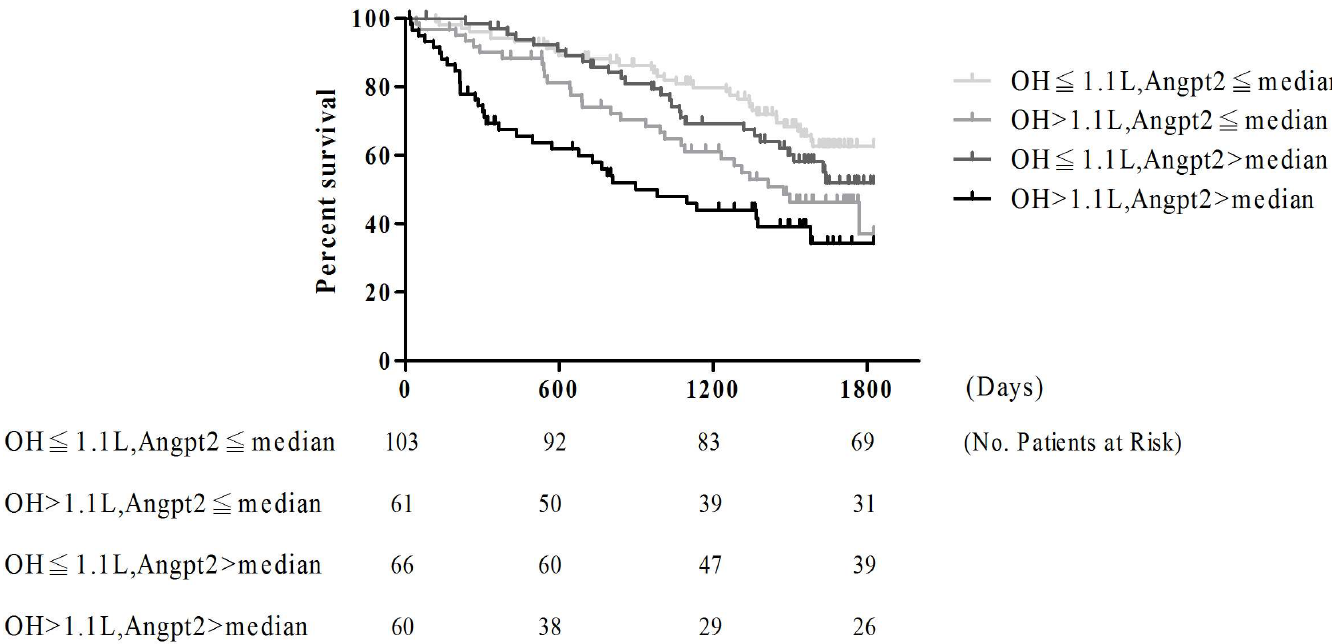
Fig 2. Kaplan-Meier survival curve for commencing dialysis in study subjects stratified by fluid status and circulating angiopoietin-2 (Angpt2)